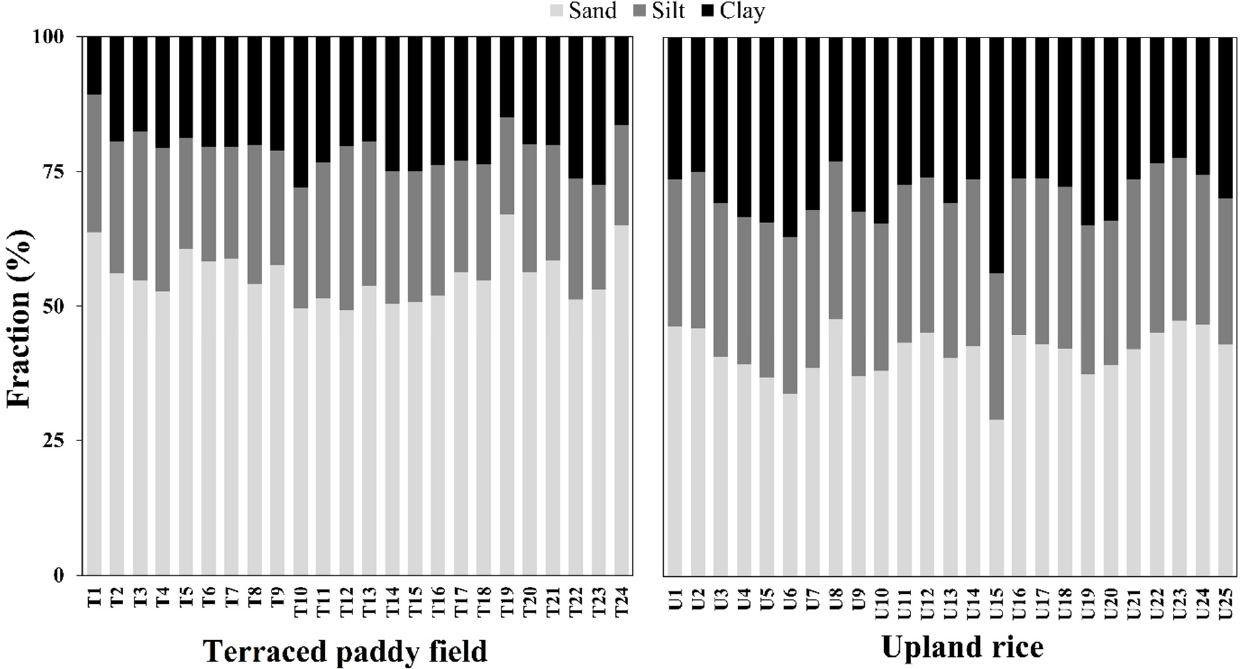
Figure 2. Particle size distribution for terraced paddy field and upland rice areas.